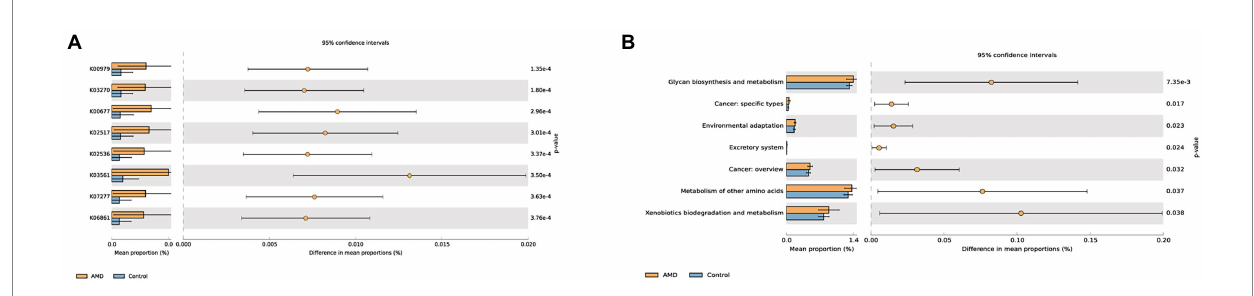
FIGURE 7 Comparison of the changes in the predicted function abundance at (A) KO and (B) KEGG level2 pathway between AMD patients and healthy controls. K00979 represents the KdsB; K03270 represents the KdsC; K00677 represents the LpxA; K02517 represents the LpxL; K02536 represents the LpxD; K03561 represents the ExbB; K07277 represents the bamA; and K06861 represents the